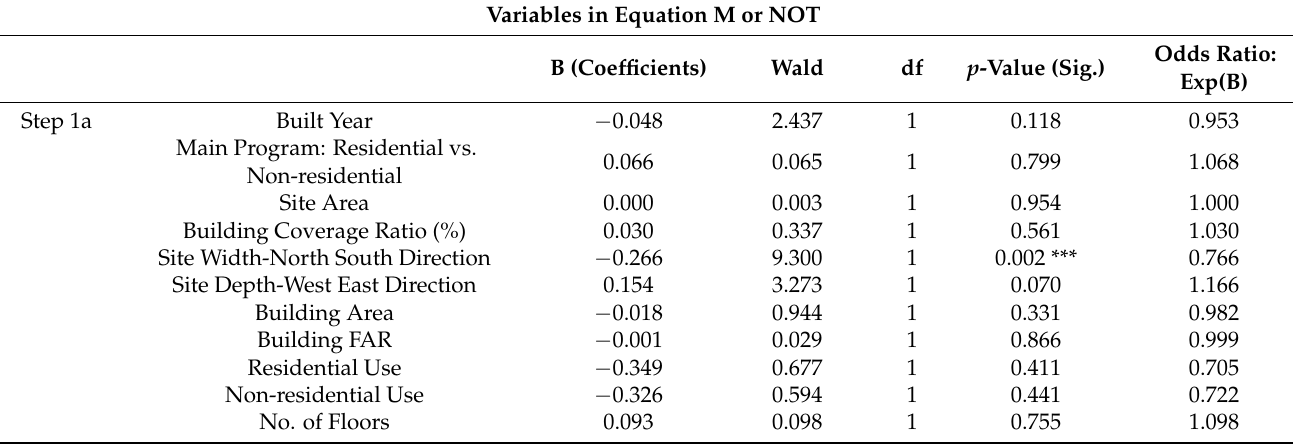
Table 6. Binary logistic regression analysis result: M or NOT.